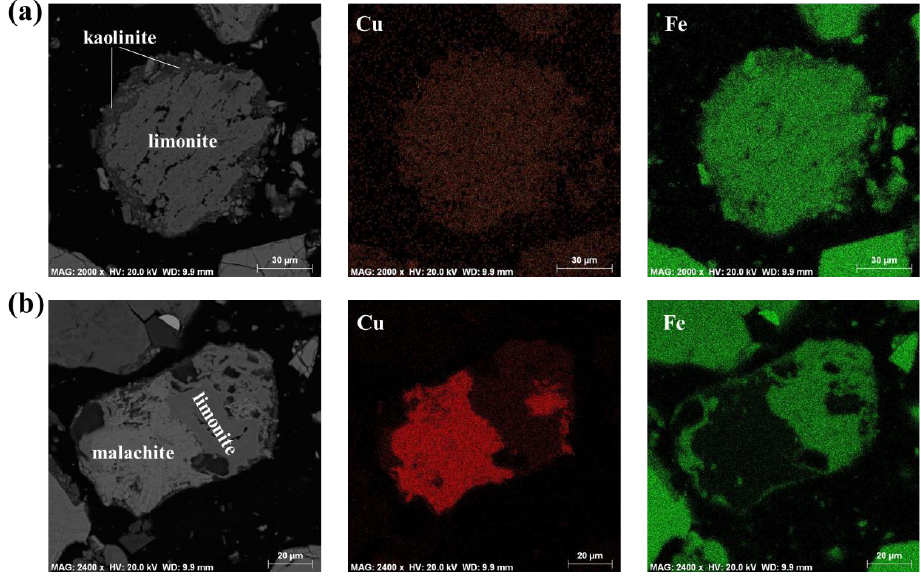
Figure 4. Surface scans of copper and iron elements in COBL ore from SEM-EDS: ( a ) limonite and kaolinite; ( b ) limonite and malachite.